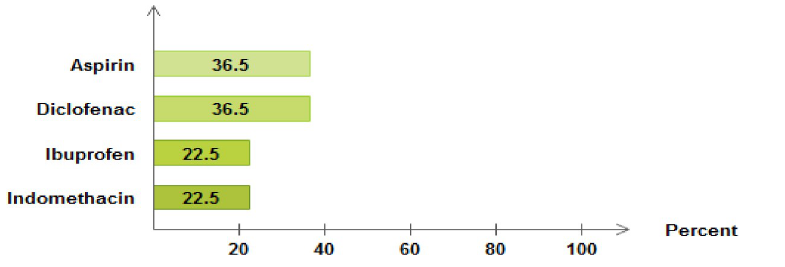
Fig 3. Severity of NSAIDs potential interactions with self-medicated